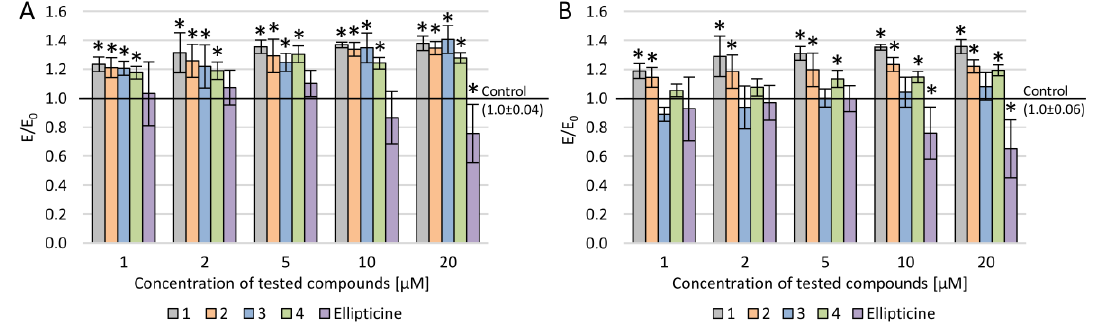
Figure 3. Rhodamine accumulation after incubation with ellipticine and new olivacine derivatives in various concentration ranges: ( A ) LoVo cells, ( B ) LoVo/DX cells; * p < 0.05 — significant difference compared to control.